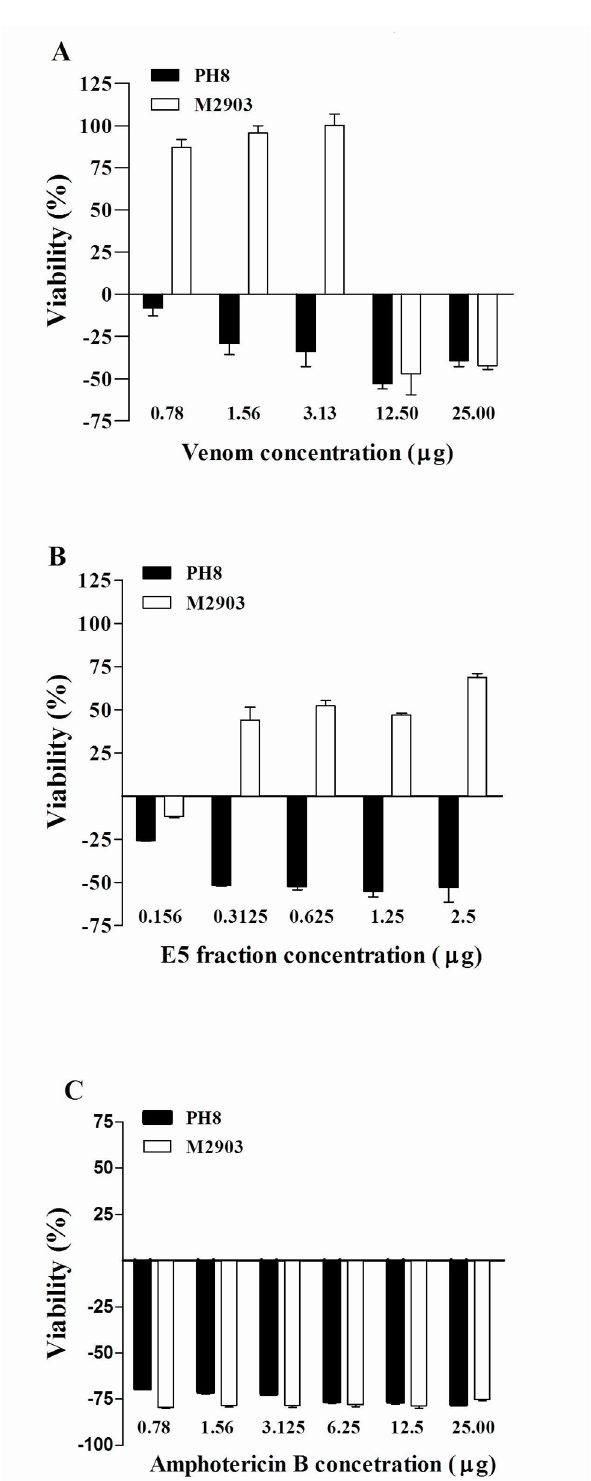
Figure 2. Leishmania viability by MTT method. ( A ) Parasites (5x10 5 cells/well) were incubated for 72 hours with B. moojeni crude venom; ( B ) B. moojeni venom E5 fraction; ( C ) amphotericin B. In the experiments, L. amazonensis (PH8) and L. braziliensis (M2903) were used. Columns shown viability (means ± standard deviations from three independent experiments) expressed in